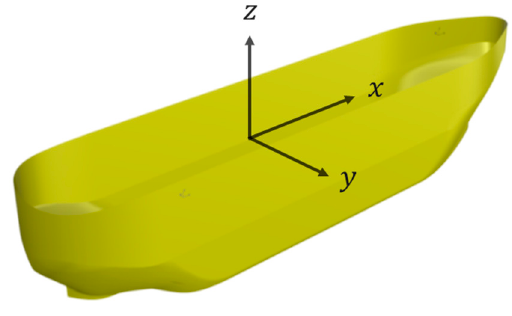
Figure 2. The 3D model of the vessel. Table 2. Principle dimensions of the vessel. Table 2. Principle dimensions of the vessel. Description